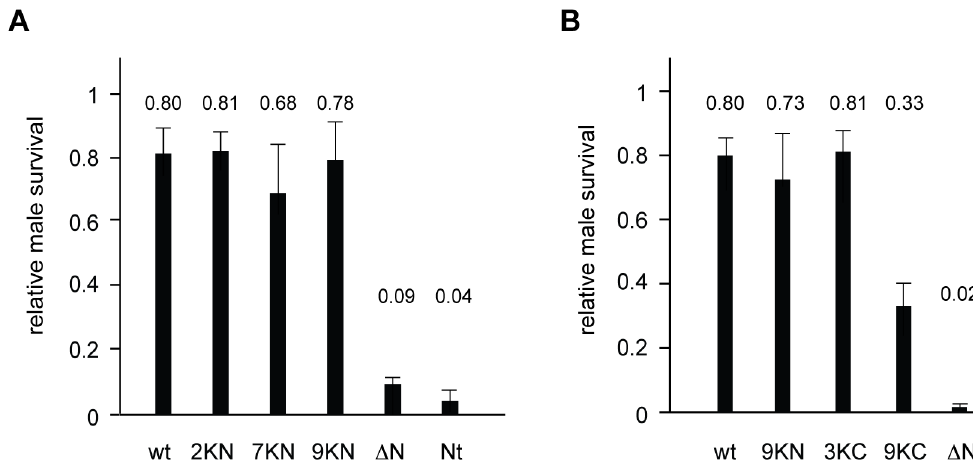
Fig 4. Functional viability rescue by MOF mutant enzymes. (A) Survival of MOF-deficient male flies upon expressionof MOF point mutants (KN). Male survival was assayed upon expressionof the indicatedMOF transgenesin the mof 2 male lethal background (see Methods). Male survival was scored as ratio mof 2 /y males to mof 2 /Fm7 females resultingfrom the same cross (relative male survival). Error bars represent the standarderror of the mean of three biologicalreplicates. (B) Survival of mof 2 males upon expressionof MOF mutants (KC) as in (A). Error bars represent the standard error of the mean of five biological replicates.